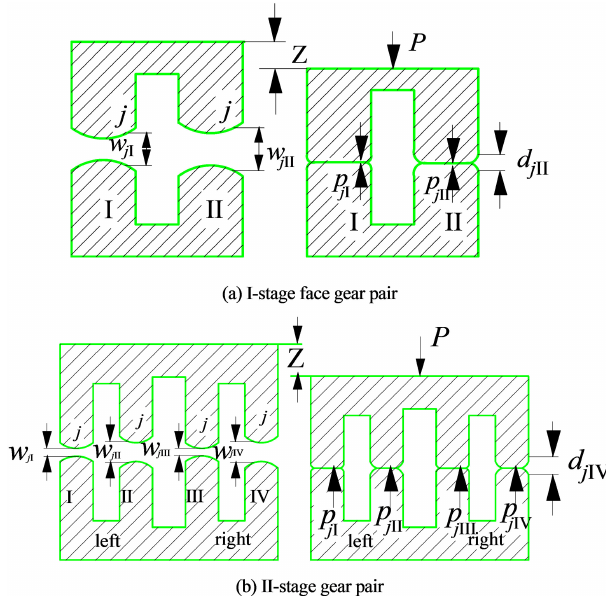
Figure 7. LTCA model of the one-stage face gear pair and two- stage gear